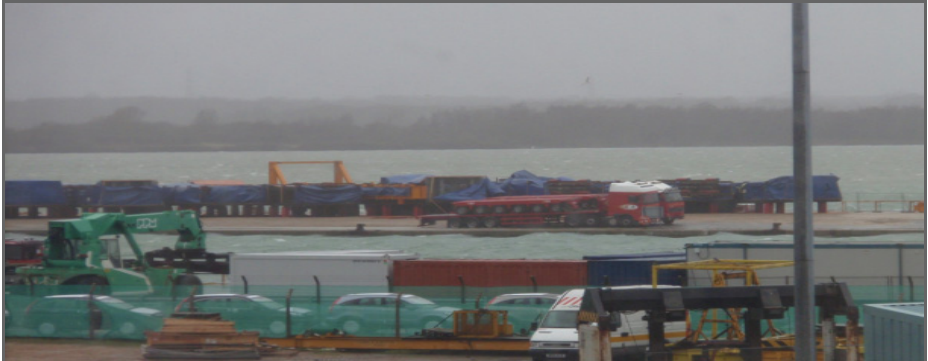
Figure 6. High water at Southampton docks on 10th March 2008 [85].